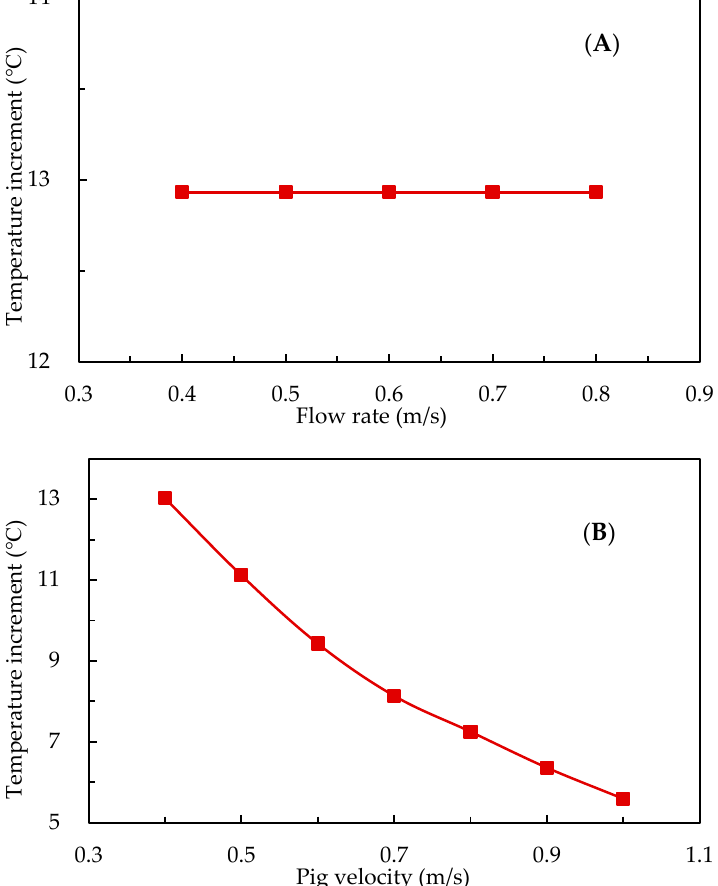
Figure 10. Effect of flow velocity and pig velocity on wax layer temperature increment. ( A ) flow velocity (original wax layer temperature is 20 °C, magnetic field frequency is 500 kHz, the electrical current intensity is 20 A, SPM-NP diameter is 18 nm, pig velocity is 0.4 m/s, induction coil turn number is 310 turns, and nanoparticle content is 10%) and ( B ) pig velocity (original wax layer temperature is 20 °C, magnetic field frequency is 500 kHz, electrical current intensity is 20 A, SPM-NP diameter is 18 nm, the flow rate is 0.4 m/s, induction coil turn number is 310 turns, and nanoparticle content is 10%).